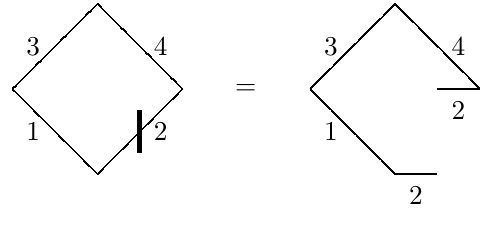
Figure 4 . Representation of A (2) .